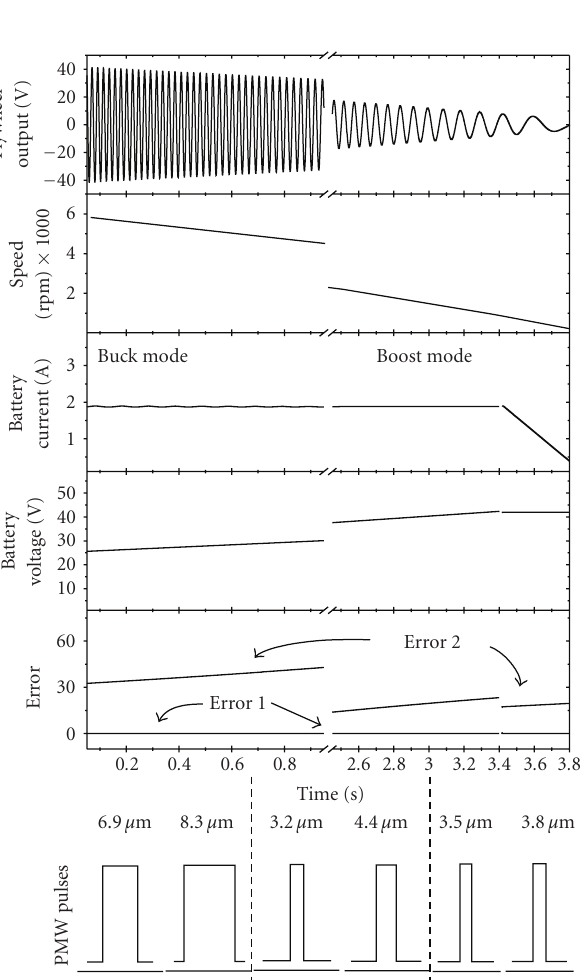
Figure 7: Battery current, voltage, control errors, and PWM pulses during buck and boost operation